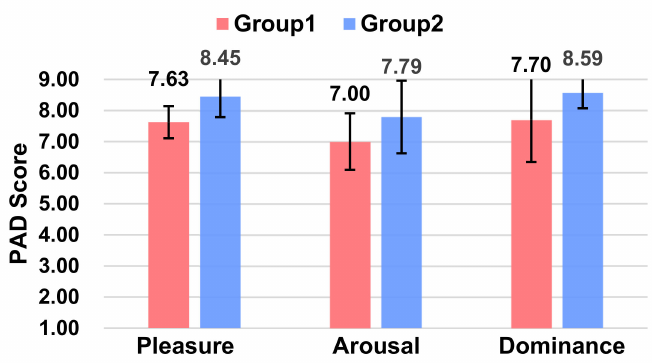
Figure 10. Ratings of Pleasure, Arousal, and Dominance between the two